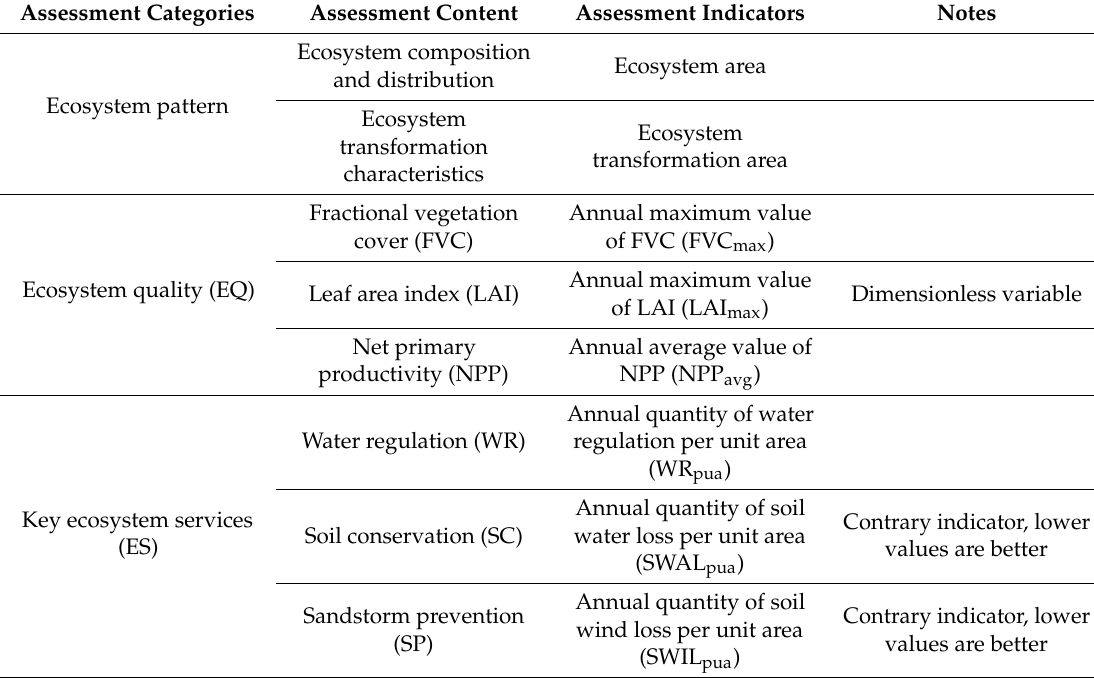
Table 2. The comprehensive assessment indicator system for ecological changes of the Grain for Green Program